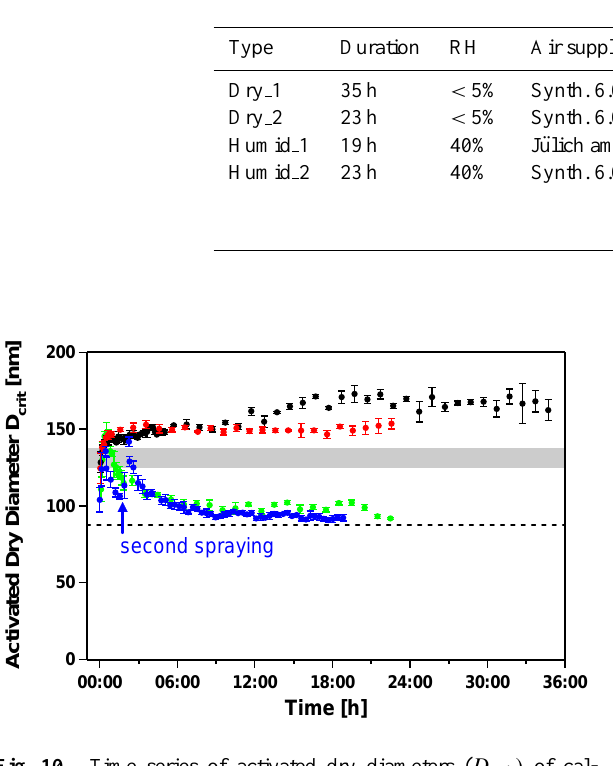
Table 5. Overview of the experiments in the Large Aerosol Chamber.